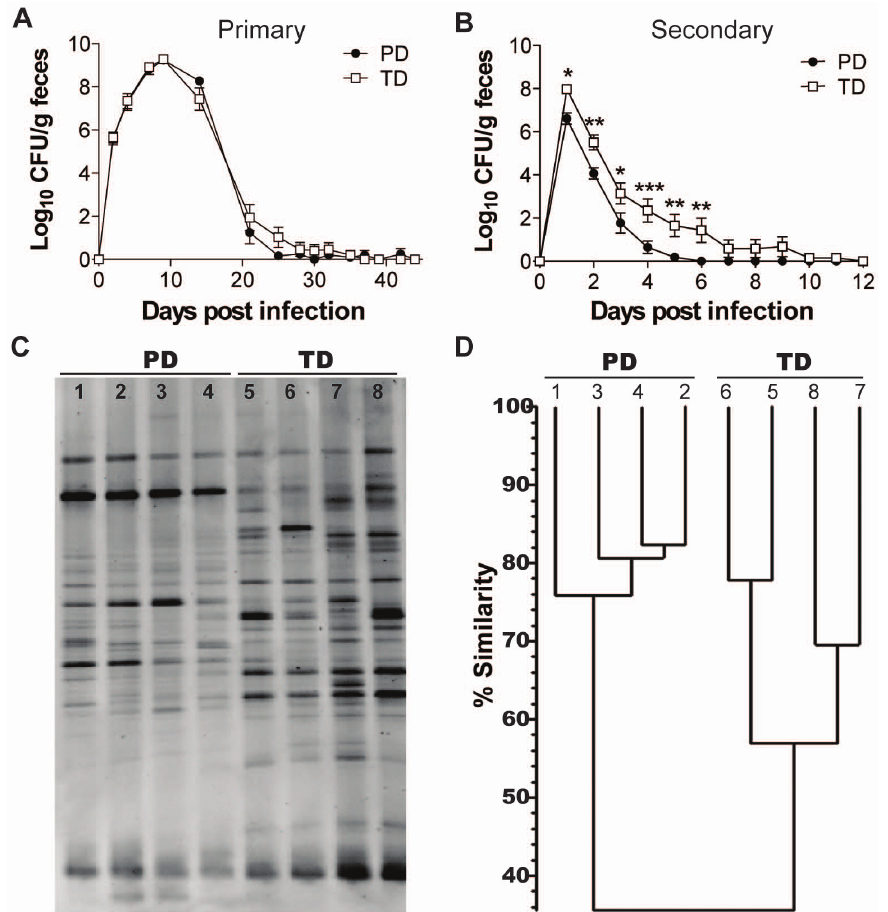
Figure 5. Diet-mediated effects on a primary and secondary infection with C.rodentium . (A) Shedding of C. rodentium in the feces following a primary infection (n=14 mice/group). (B) Shedding of C. rodentium in the feces following a secondary infection (n=14 mice/group). Values are the mean + / 2 SEM. TD was significantly different from PD (*P , 0.05, **P , 0.01, ***P , 0.001, two-way ANOVA with Bonferroni post-tests). (C) Fecal DNA was collected from PD-fed (lanes 1–4) and TD-fed mice (lanes 5–8) prior to secondary infection and (D) cluster analysis of the similarity of the DGGE banding patterns from panel C. CFU, colony forming units, DGGE, denaturing gradient gel electrophoresis; PD, purified diet; TD, Teklad diet.